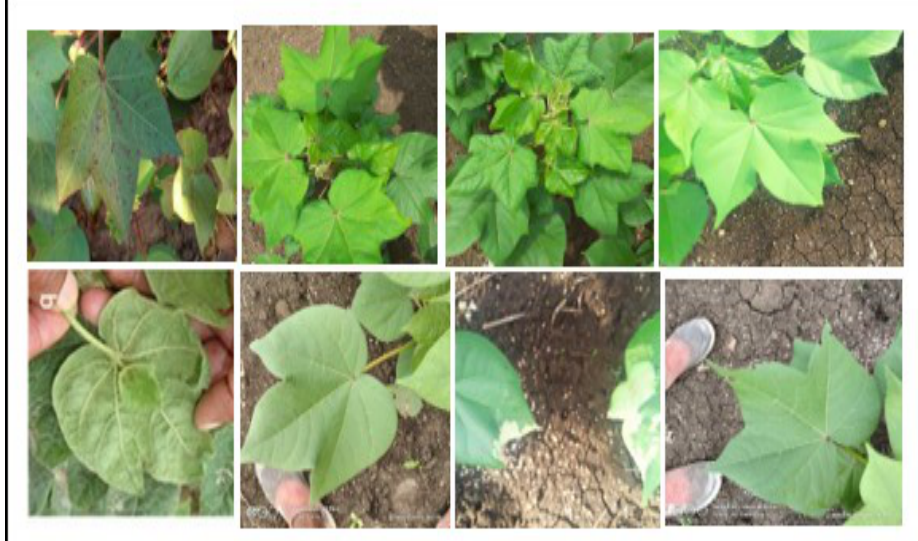
Figure 2. Cotton Disease Dataset